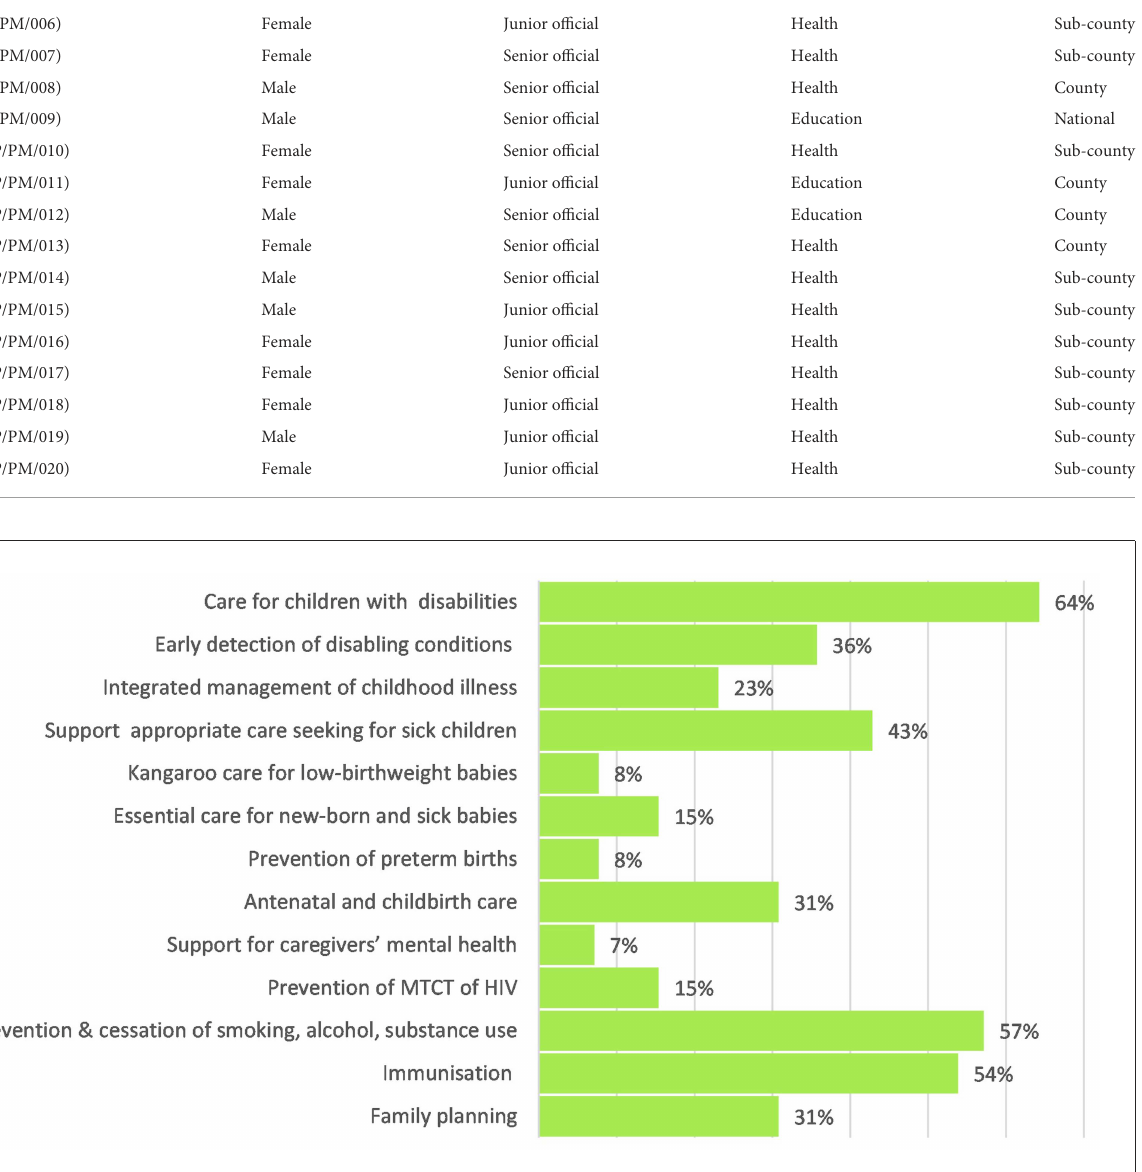
FIGURE2 Coverage of “Good Health” within national